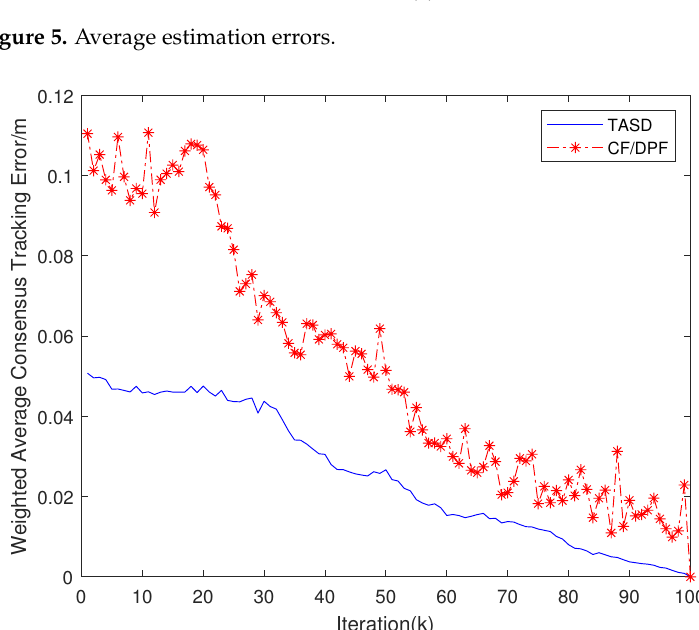
Figure 6. Weighted consensus tracking